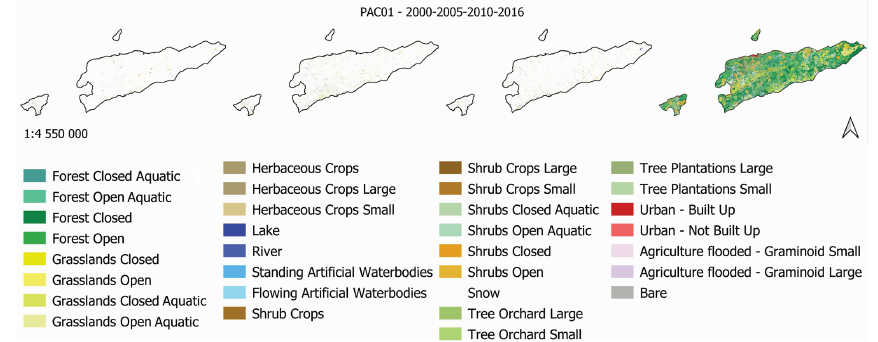
Figure 8. Timor-Leste Key Landscape for Conservation – modular classification level. The boundaries (black polygons) represent the country boundary. Both land cover and land cover change maps are presented for